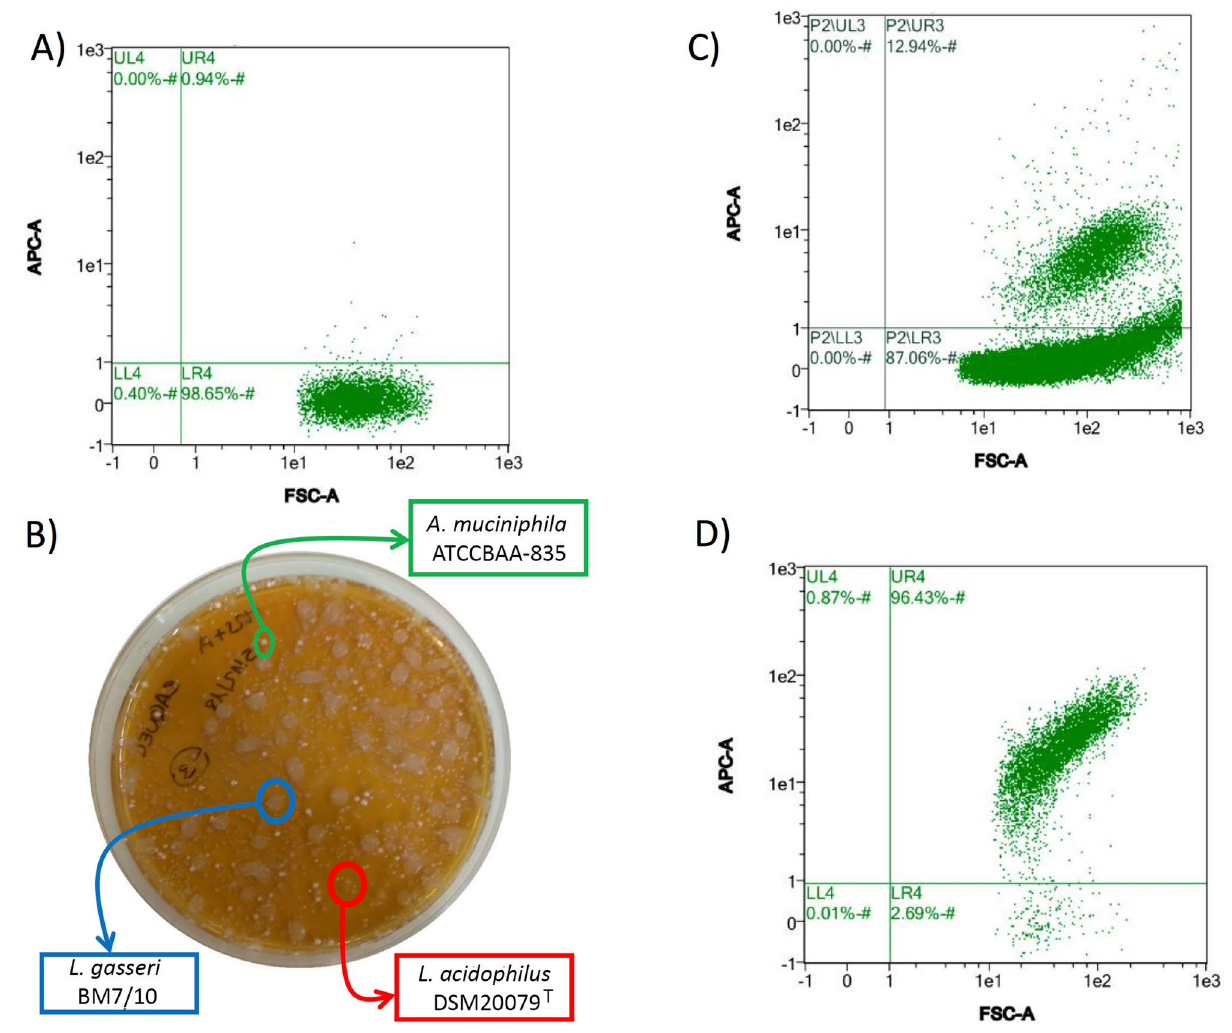
Figure 4. (A) Dispersion diagrams of representative FC experiments showing the APC-specific fluorescence in a synthetic microbiota depleted of L. acidophilus DSM20079 T . (B) Representative Petri dish showing the bacteria corresponding to L. acidophilus DSM20079 T enriched fraction and their identifications based on 16S rRNA gene sequencing is also represented. (C) Dispersion diagrams of representative FC experiments in the L. acidophilus DSM20079 T enriched fraction showing the presence of non-fluorescent bacteria, and (D) in the L. acidophilus DSM20079 T enriched fraction with a previous treatment with trypsin, and which contained only fluorescent bacteria corresponding to L. acidophilus